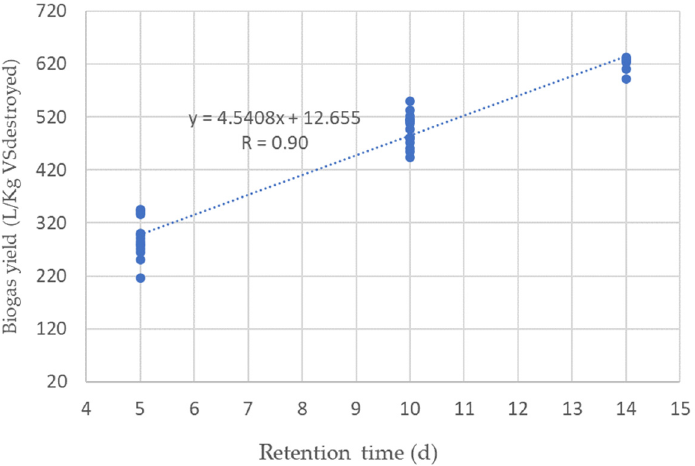
Figure 5. Dependence of biogas yield on the substrate retention time (RT) in TSB.